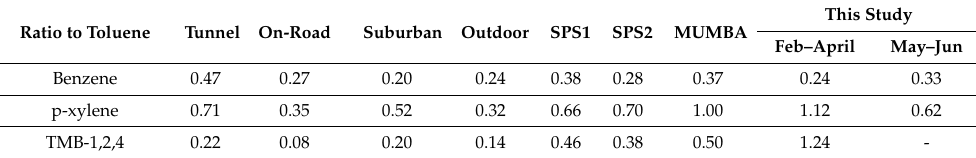
Table 7. Mean AVOC ratios normalised to